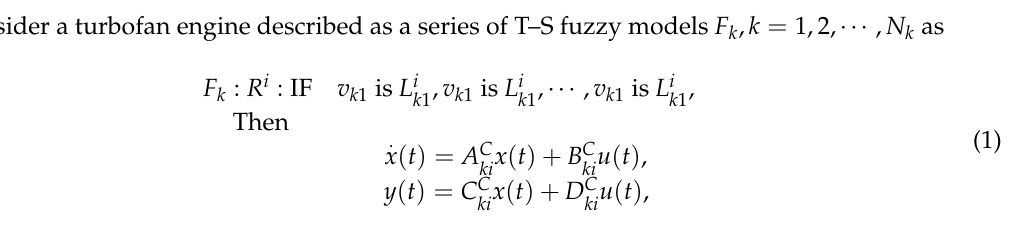
Figure 1. Diagram of a turbofan engine.